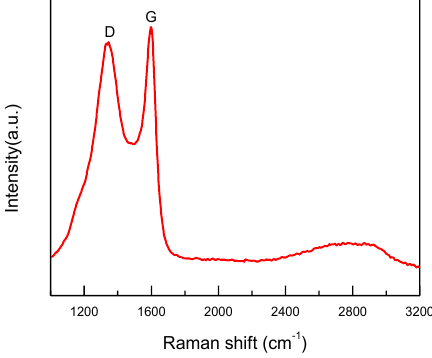
layers through a pyrolysis process. Then, the a-C layers in direct contact with the Cu nanoparticles were converted to graphitic ordering due to the catalytic effect of Cu [24]. Thus, the copper nanoparticles might have a graphene-like inner shell, and an amorphous outer carbon shell. Thus, the product “f” consisted of copper nanoparticles encapsulated in the carbon-shelled mesosphere, and “f” was labeled as Cu@MC.